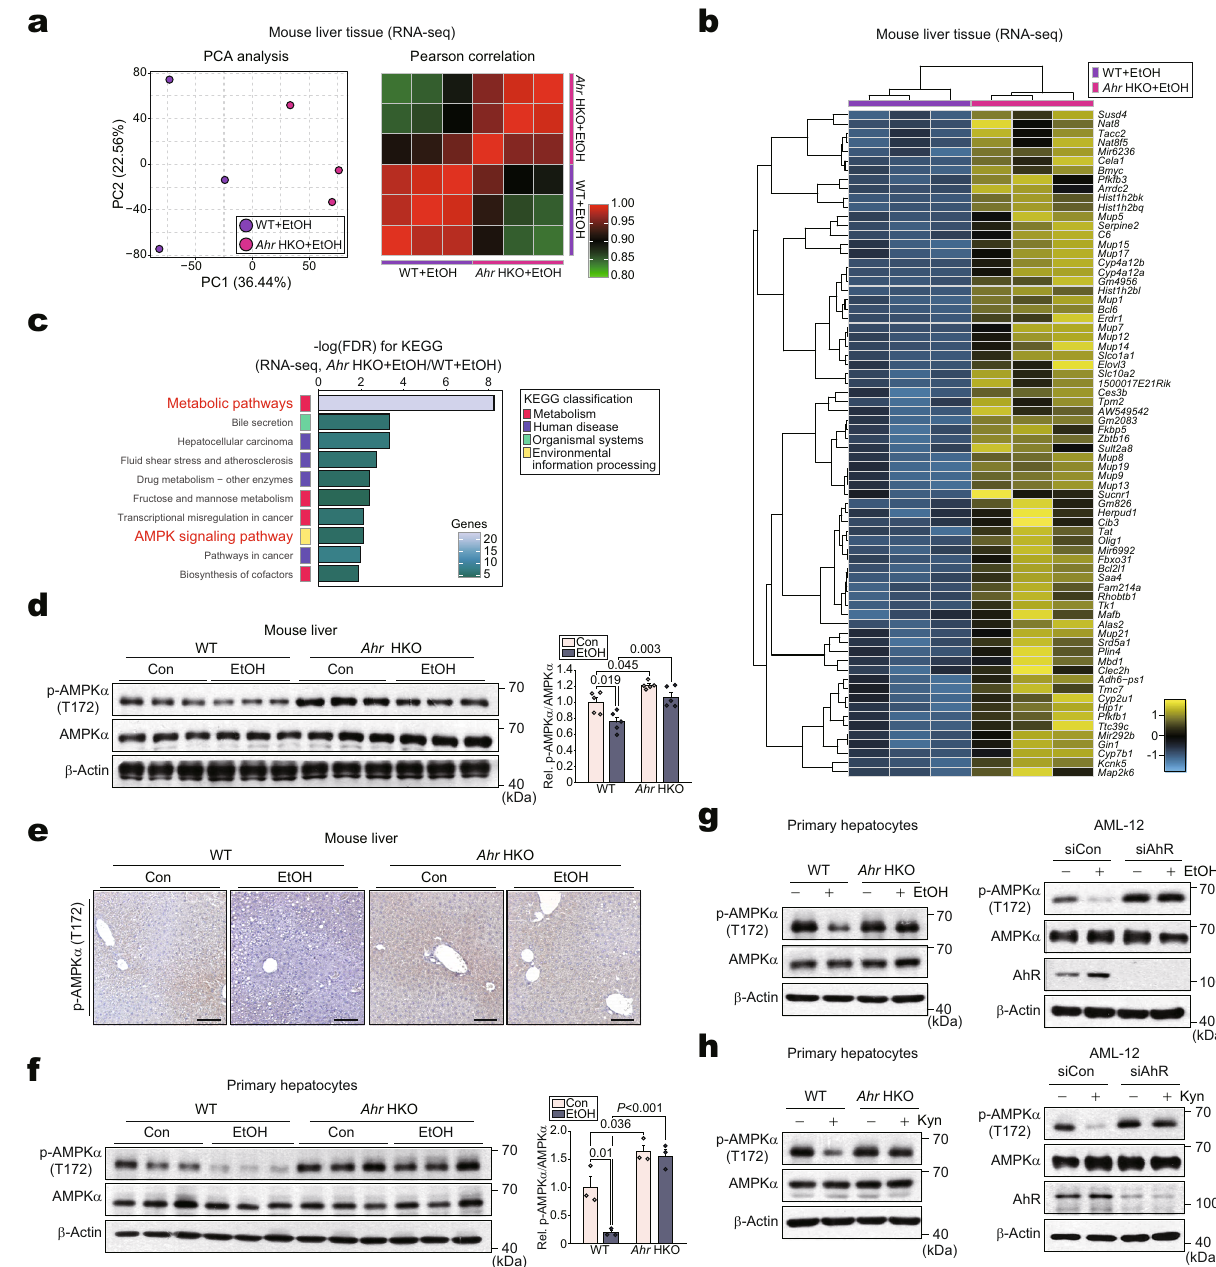
Fig. 4 | AhR-dependent inhibition of p-AMPK α in mice or hepatocytes treated withalcohol.a PCAscoreplot(left)andheatmapofthePearsoncorrelationmatrix (right)basedonthehepatictranscriptomedataobtainedfromWTor Ahr HKOmice fed Lieber-DeCarli diet for 5 weeks ( n =3 each; darker green, closer negative cor- relation; darker red, closer positive correlation). b Heatmap and hierarchical cor- relationanalysesofDEGsusingthesamedataasin( a )(DEGsof P <0.05andFC>2). TheDEGswerehierarchicallyclusteredandpresentedasheatmapaccordingtothe row Z -score (darker blue, stronger downregulation; darker yellow, stronger upre- gulation). c Bar graphs based on KEGG analysis to identify functional processes controlled by Ahr HKO using the same data as in ( a ). FDR and genes are presented as bar graphs (FDR <0.01). d Immunoblots from the liver homogenates obtained from the mice subjected to control or Lieber-DeCarli diets for 5 weeks (left) and